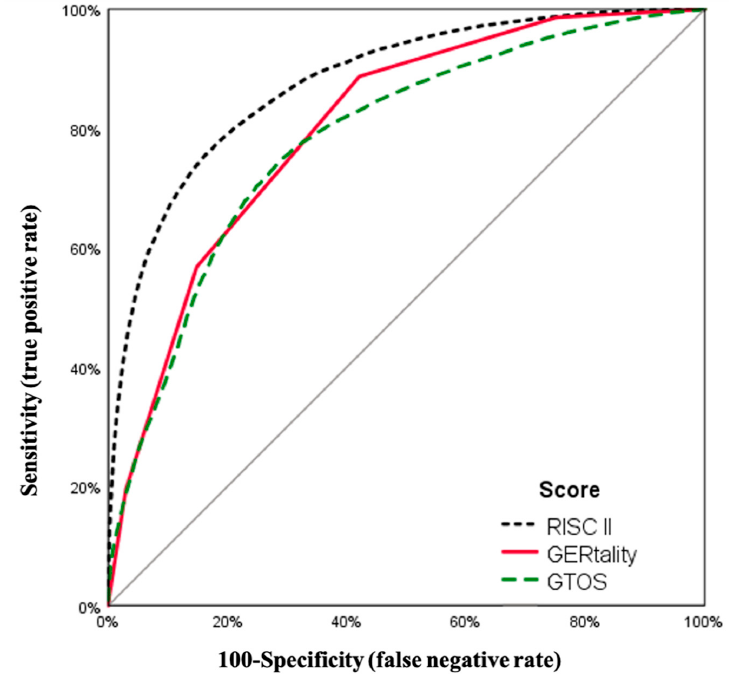
Figure 4. ROC (receiver operating characteristic) analysis.